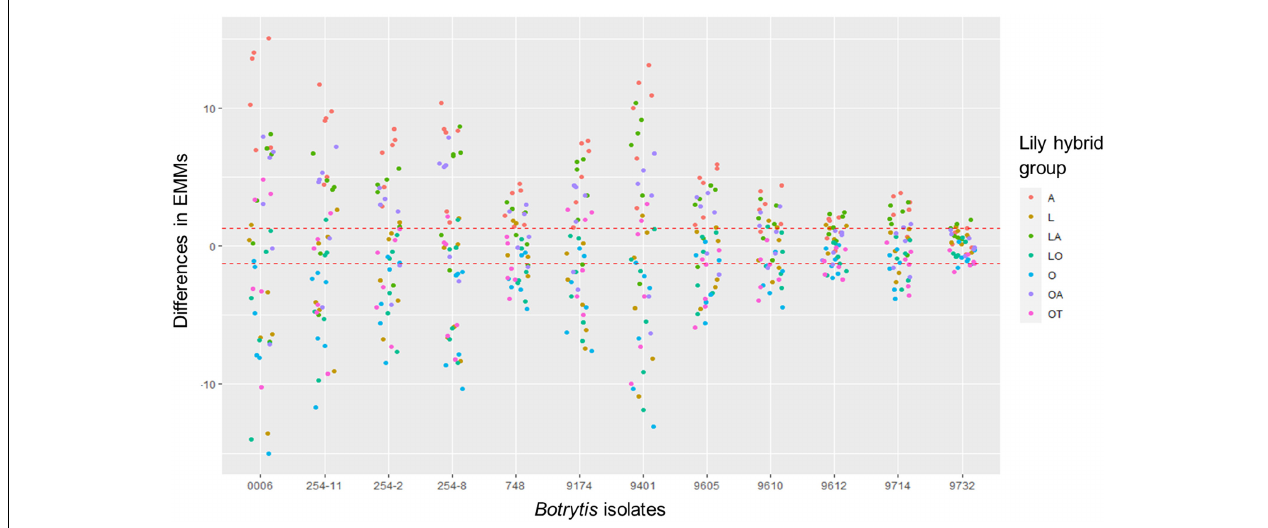
FIGURE 5 | Dot plot showing differences in EMMs of lesion diameters on lily leaves in early spring for a given B. elliptica isolate, calculated using lily hybrid group as predicted factor. Red dotted line indicates the average p -value cut off for estimated differences which are significantly different from 0 ( p > 0.05). P -values were adjusted using Tukey’s comparison for a family of 84